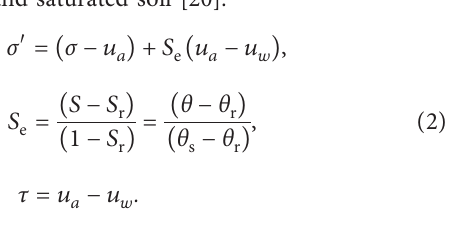
Figure 2: Detailed geological profile of the